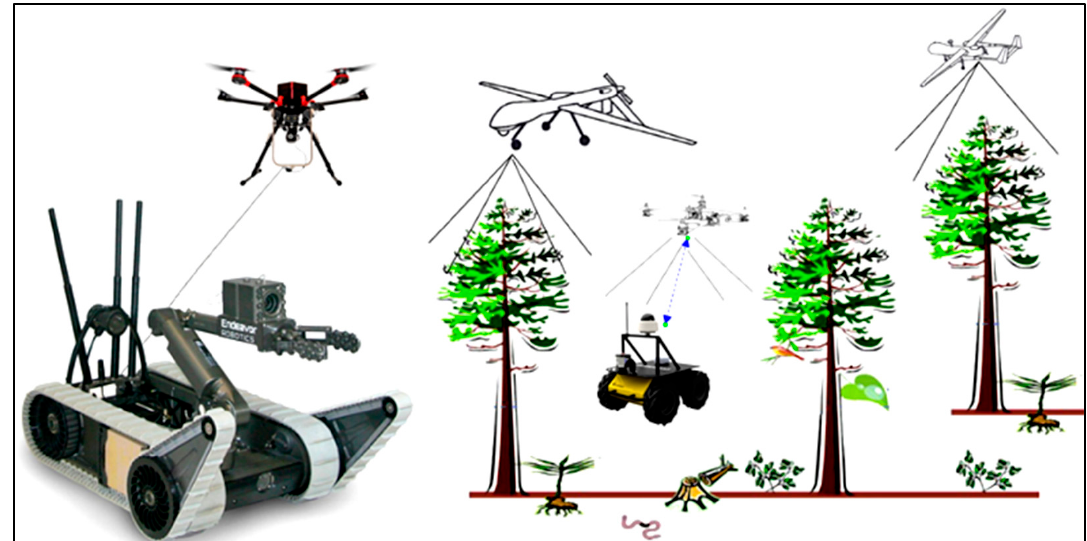
Figure 3. Schematic views of collaborations between UAVs and UGVs (Figure from [82]).